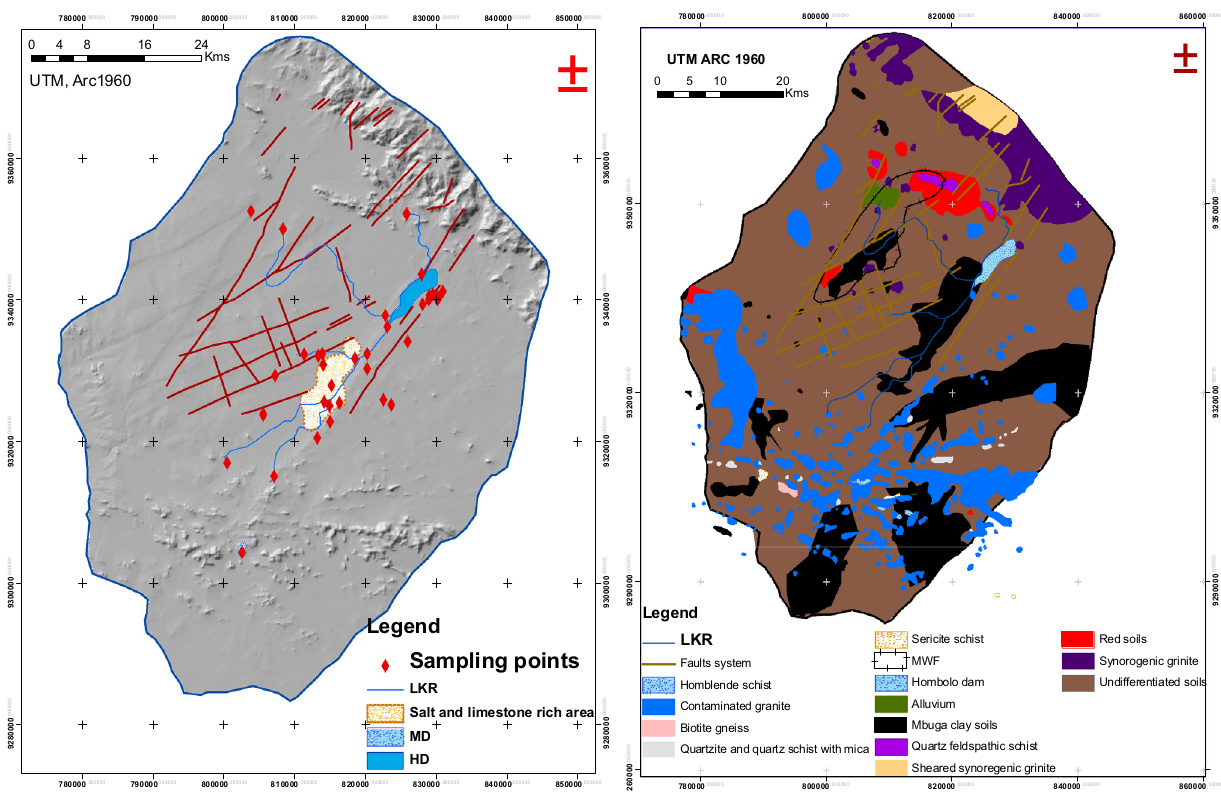
Fig. 1 A map showing the location of the study area, sampling points, geological map and Hombolo and Matumbulu dams of Dodoma